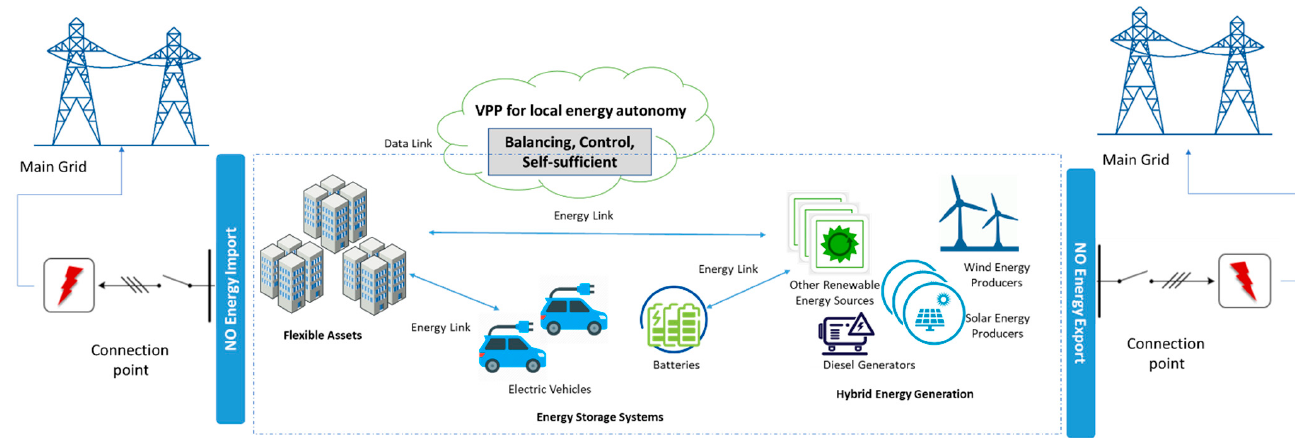
Figure 5. VPP for local energy autonomy.